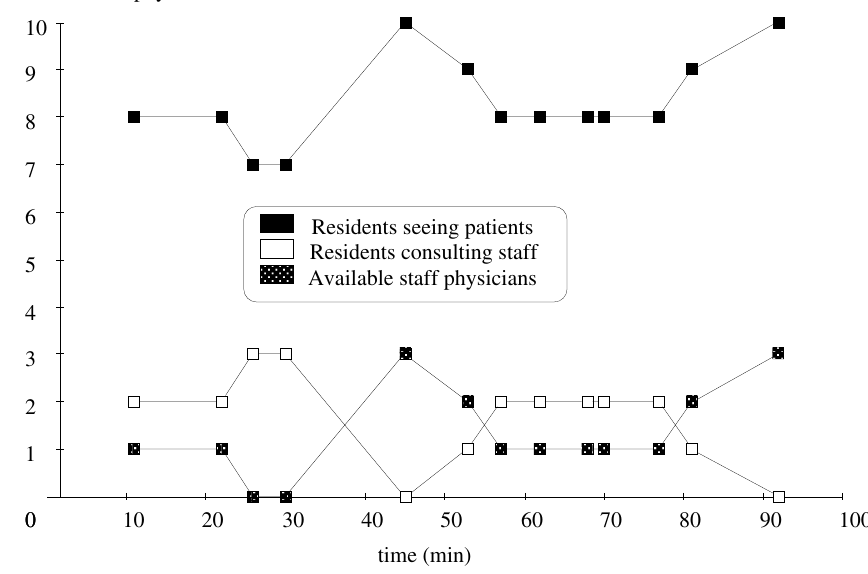
The number of physi- cians in the different states as a function of time. The figure shows how the state of the system may change over time when the model is executed via simula-